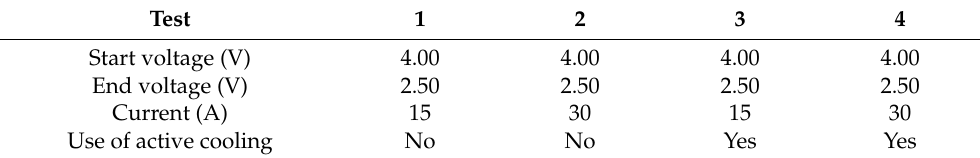
Table 5. Test conditions of single cell.